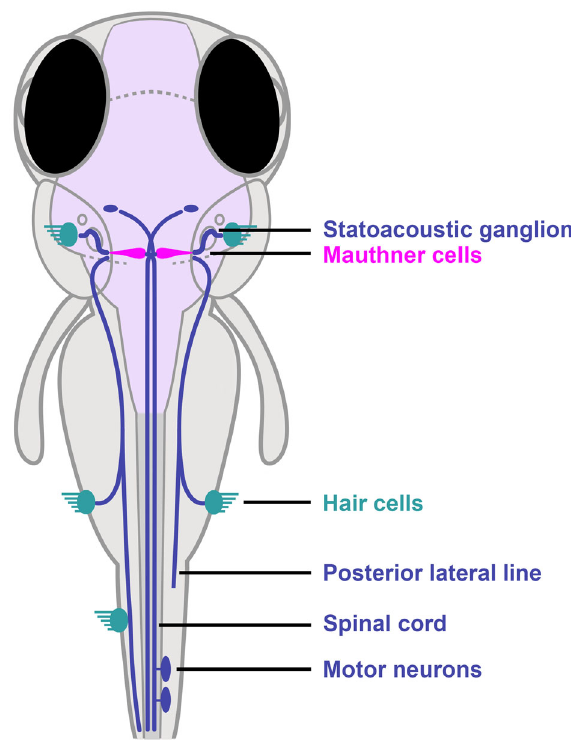
Fig. 1 Startle response circuit in zebra fi sh. The proper execution of the auditory-evoked startle response relies on hair cells to sense the auditory stimulus, Mauthner cells to integrate the signals, and motor neurons and musculature to execute the startle